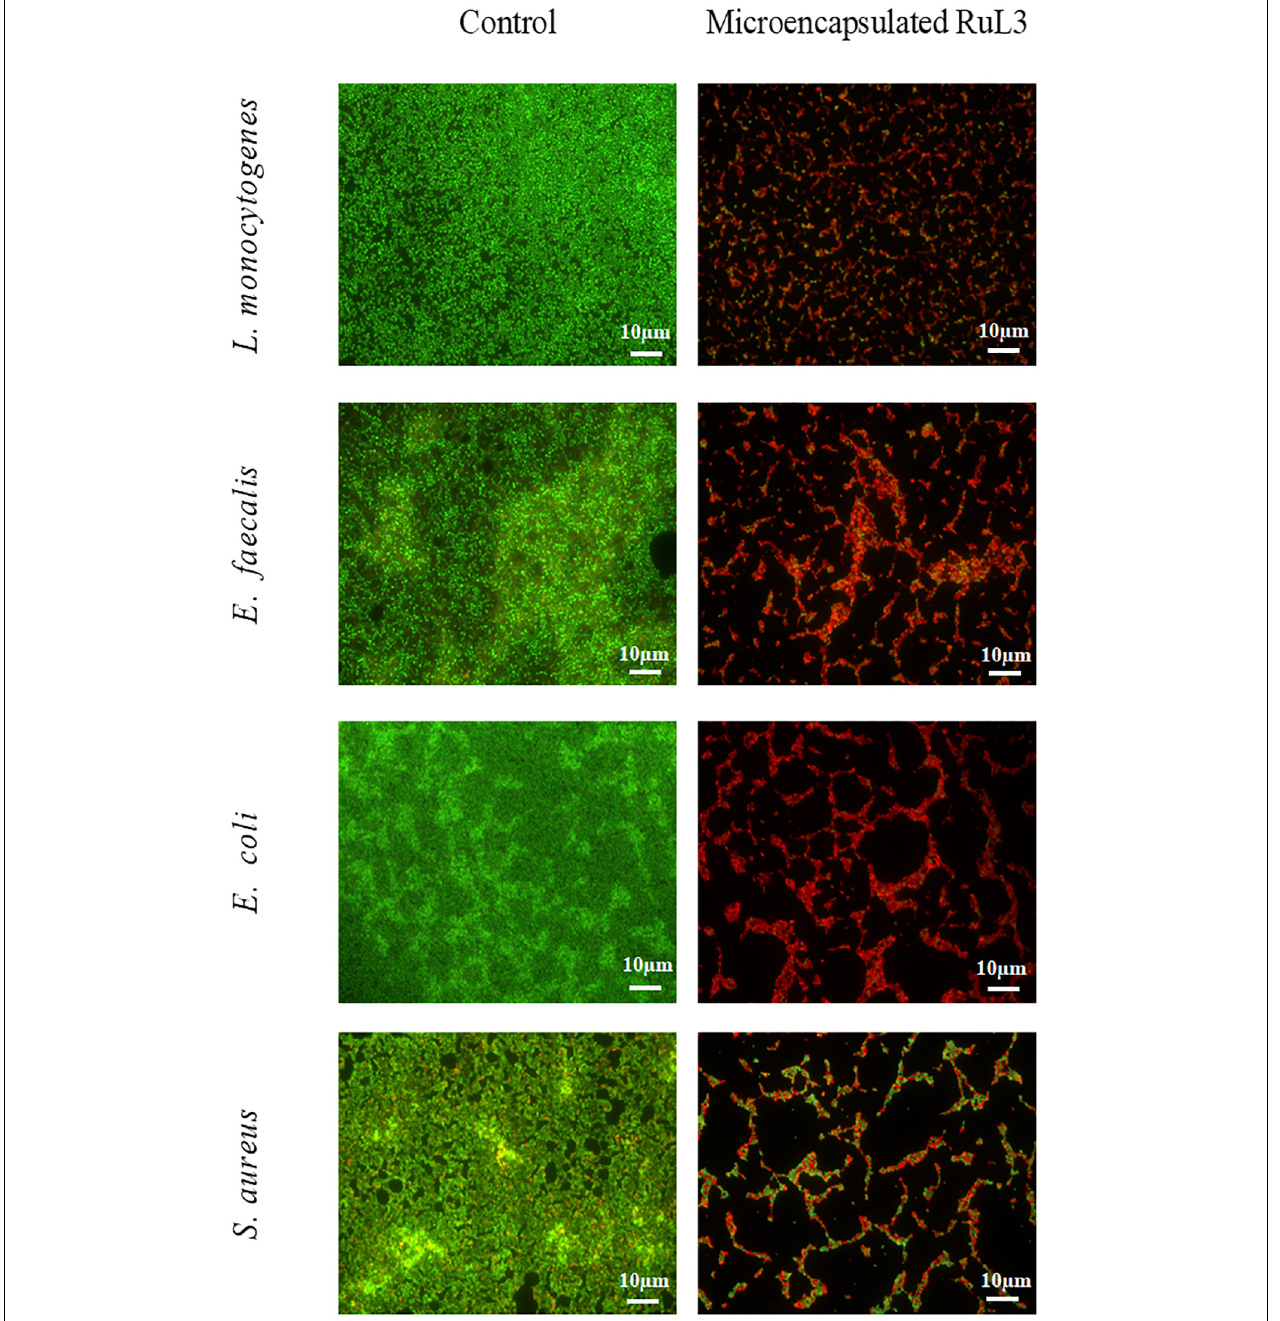
FIGURE 3 | Fluorescence microscope images of Listeria monocytogenes , Enterococcus faecalis , Escherichia coli , and Staphylococcus aureus biofilm cells grown at 37 ◦ C for 24 h on stainless steel after treatment with microencapsulated RuL3 at the minimum inhibitory concentration (MIC). Cells were visualized after staining with SYTO-9 (green fluorescence for living bacteria) and propidium iodide (red fluorescence for dead bacteria). The control represents cells treated with tryptone salt buffer.